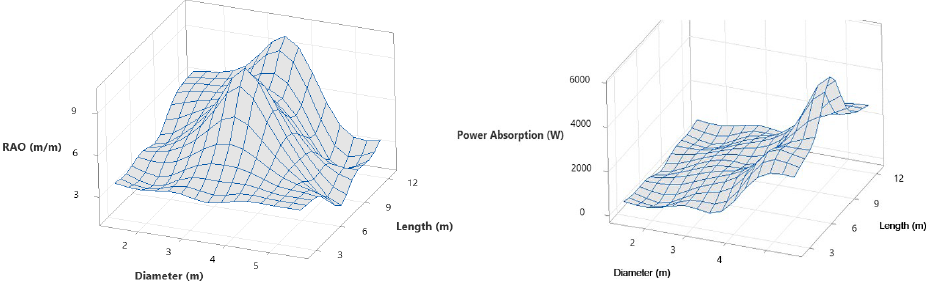
Figure 17. Surface Plot Corresponding to: RAO ( Left ) and Maximum Power Absorption ( Right ) versus PA Diameter and Gap Length.